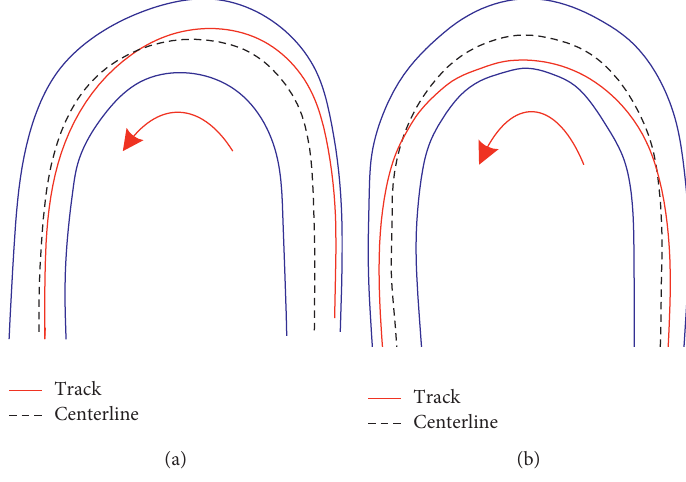
Figure 11: Vehicle occupying the opposite lane on hairpin